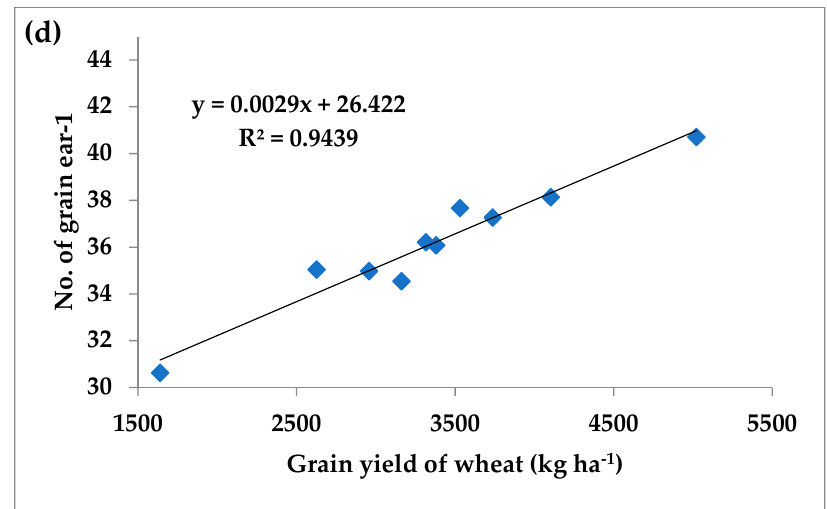
Figure 5. ( a − d ) Relationship between wheat grain yield and other growth and yield parameters ( a ) grain yield and test weight, ( b ) grain yield and number of ear head, ( c ) grain yield and number of tillers, and ( d ) grain yield and number of number of grains per ear of wheat.